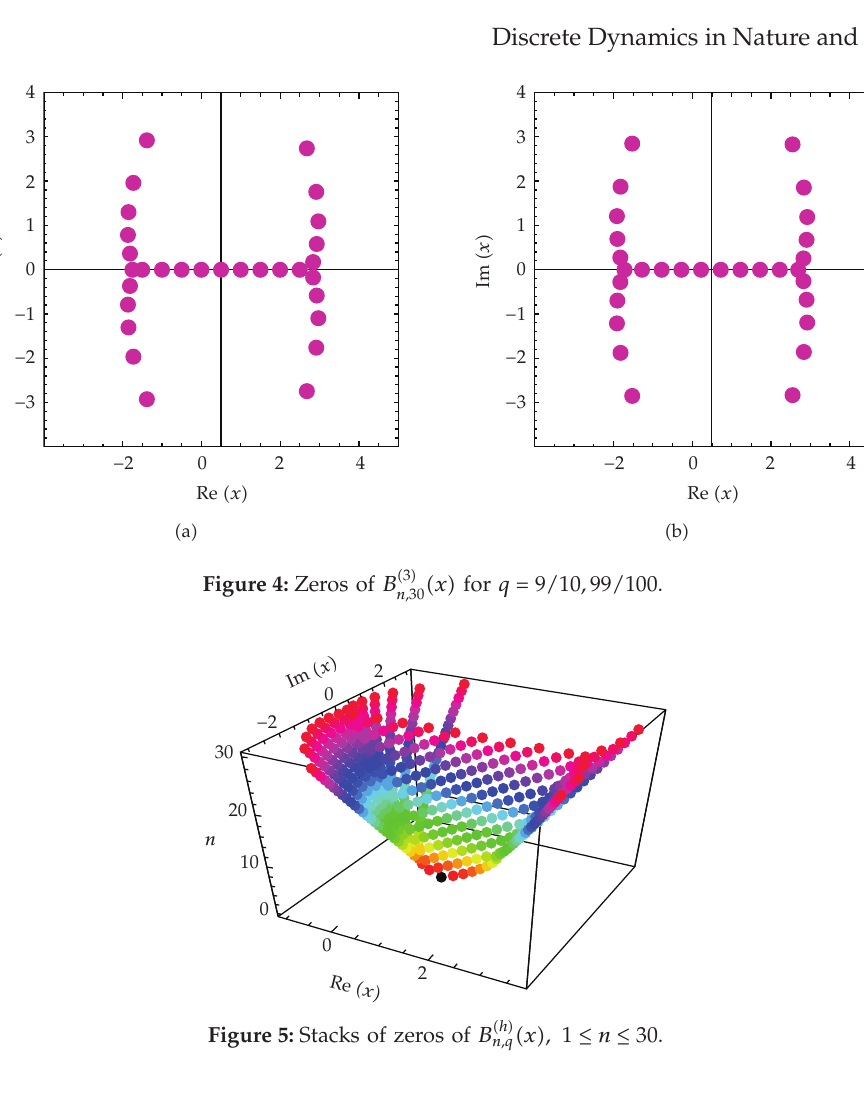
(cid:2) h (cid:3) (cid:2) x (cid:3) n,q